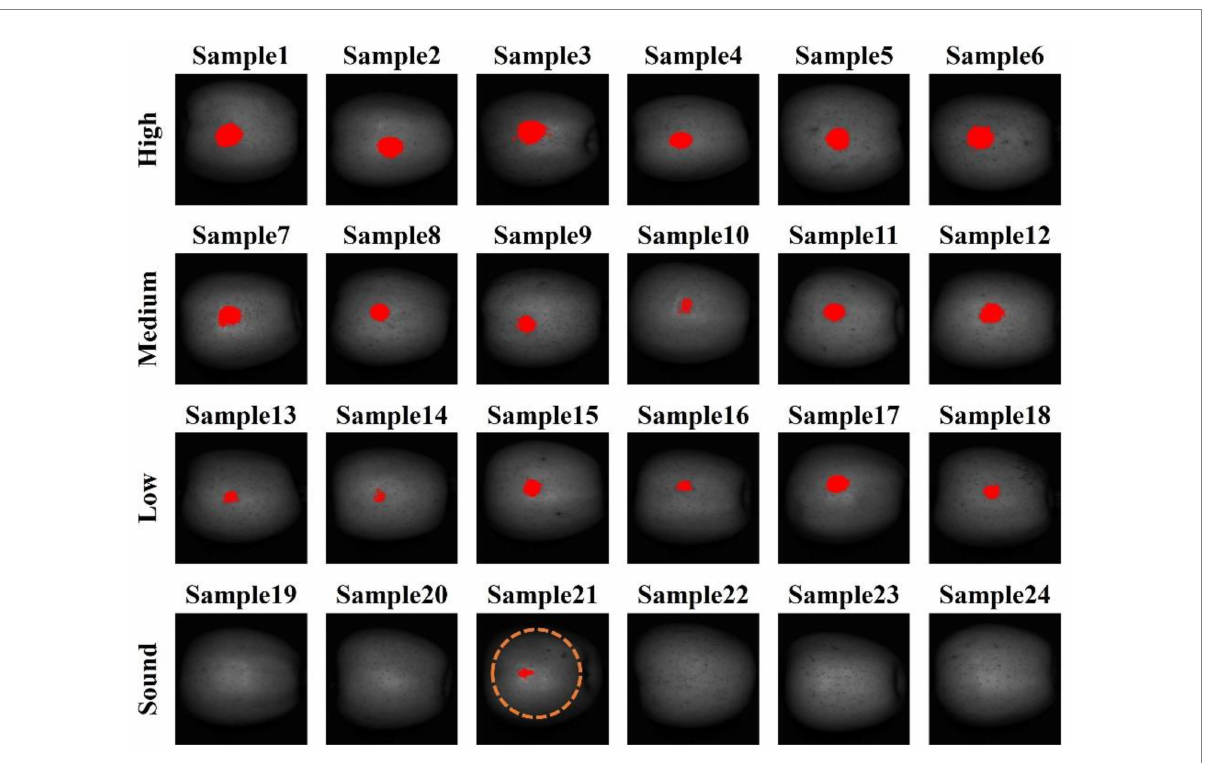
FIGURE 8 Bruise classification images from LDA model with combination